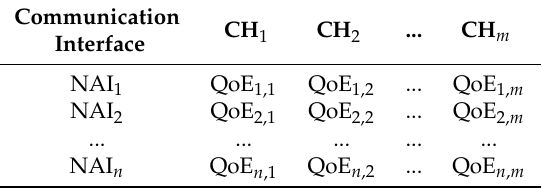
Table 5. Communication Table for Node x